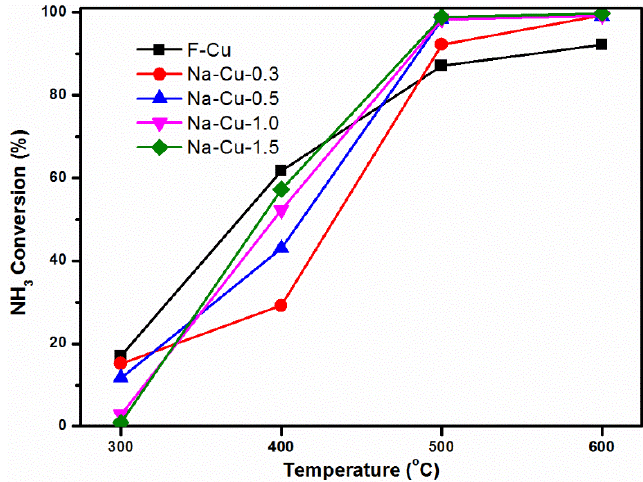
Figure 11. NH 3 oxidation results of fresh and Na-impregnated catalysts. The reaction was carried out with a feed containing 500 ppm NH 3 , 10% O 2 , 3% H 2 O, balance N 2 , and with GHSV = 80,000 h − 1 .